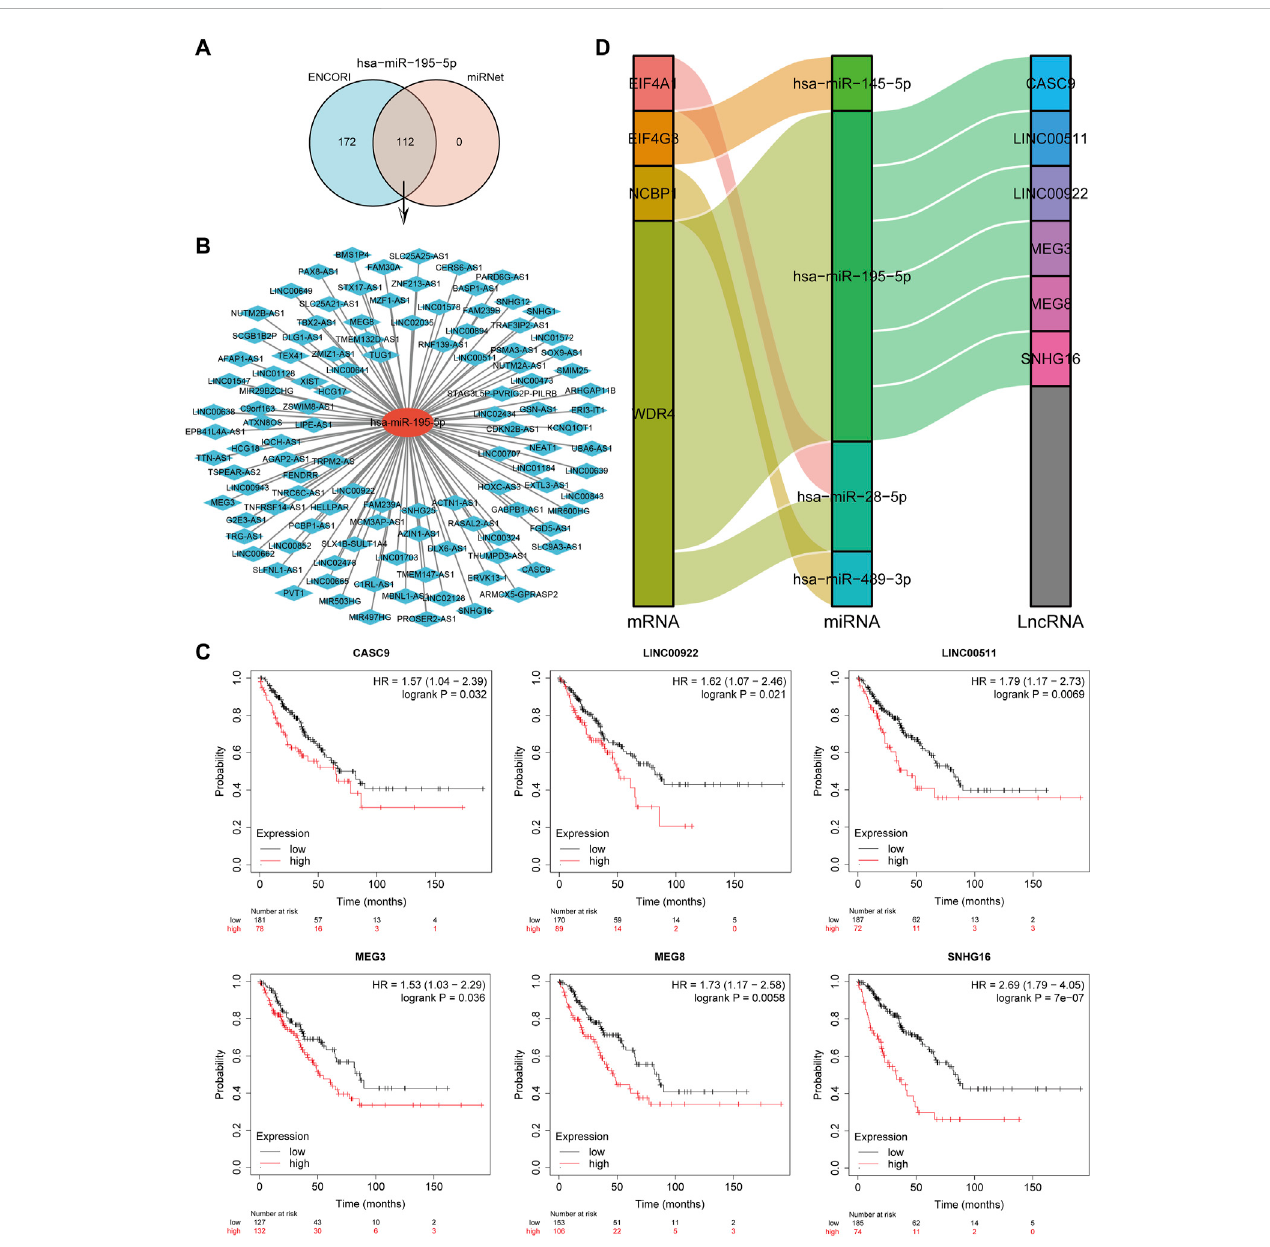
FIGURE 13 Screening of theregulatory axis oflncRNA-miRNA-CRGs insarcomas. (A) Potential lncRNAs associated with hsa-miR-195-5ppredicted by ENCORI and miRNet databases. (B) Potential miRNA-lncRNA network constructed using Cytoscape software. (C) Expression and prognosticvalue of six potential lncRNAs in sarcomas. (D) LncRNA-miRNA-mRNA triple regulatory network affecting the prognosis of